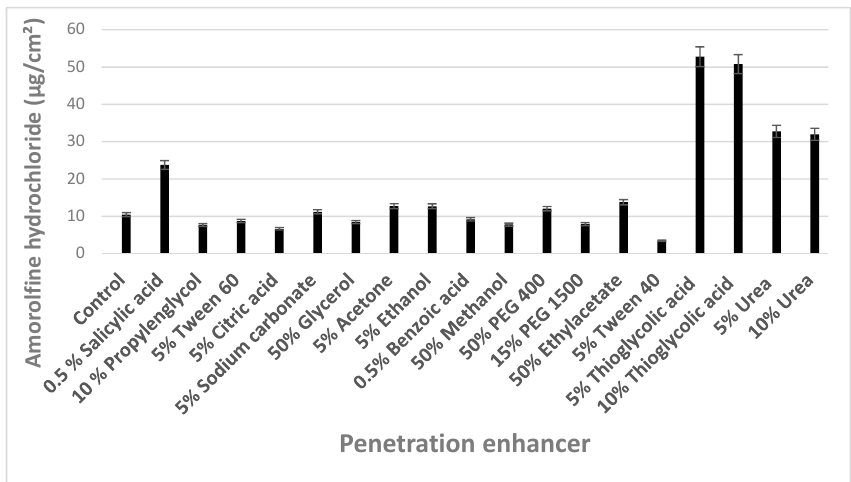
Figure 1. Quantity of amorolfine hydrochloride absorbed by hoof lamella after 24 h pretreatment in solutions of penetration enhancers. Control—acidified water (pH 3).